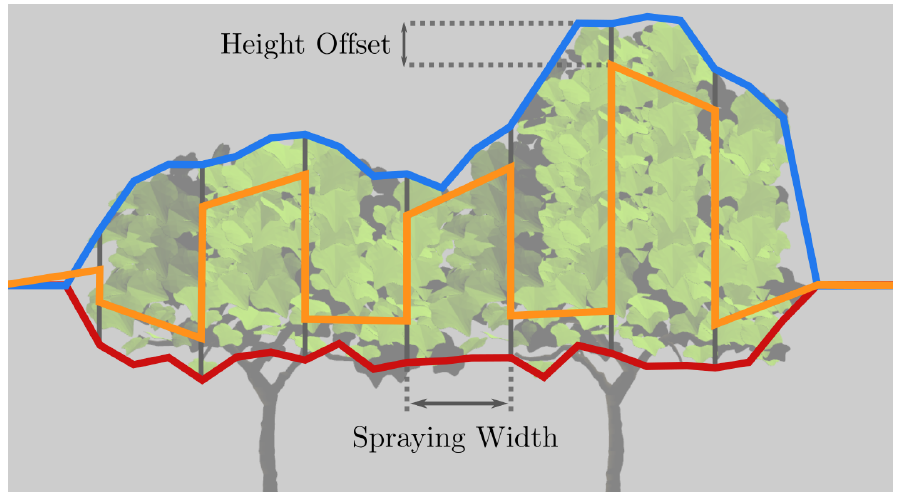
Figure 4. A reference lawnmower trajectory is shown with an orange line. The canopy descrip- tion is represented by a blue and a red line, representing the upper and lower boundaries of the foliage,